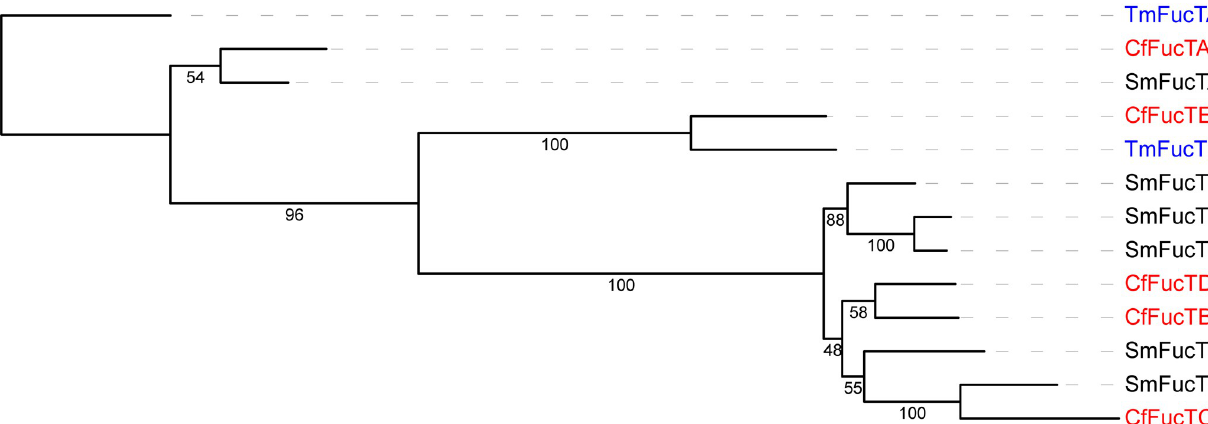
Fig 3. Phylogenetic tree of Cardicola forsteri fucosyltransferases. Outgroup-rooted maximum likelihood tree of the fucosyltransferases from Cardicola forsteri (shown in red) in Table 5 with fucosyltransferases from Schistosoma mansoni and Thunnus maccoyii (as the outgroup in blue): SmFucTA (G9HW08), SmFucTB (E2EAI5), SmFucTC (E2EAI6), SmFucTD (E2EAI7), SmFucTE (E2EAI8), SmFucTF (E2EAI9), TmFucTA (XP_042266362.1), TmFucTE (XP_042246885.1). Bootstrap values are shown on the branches.